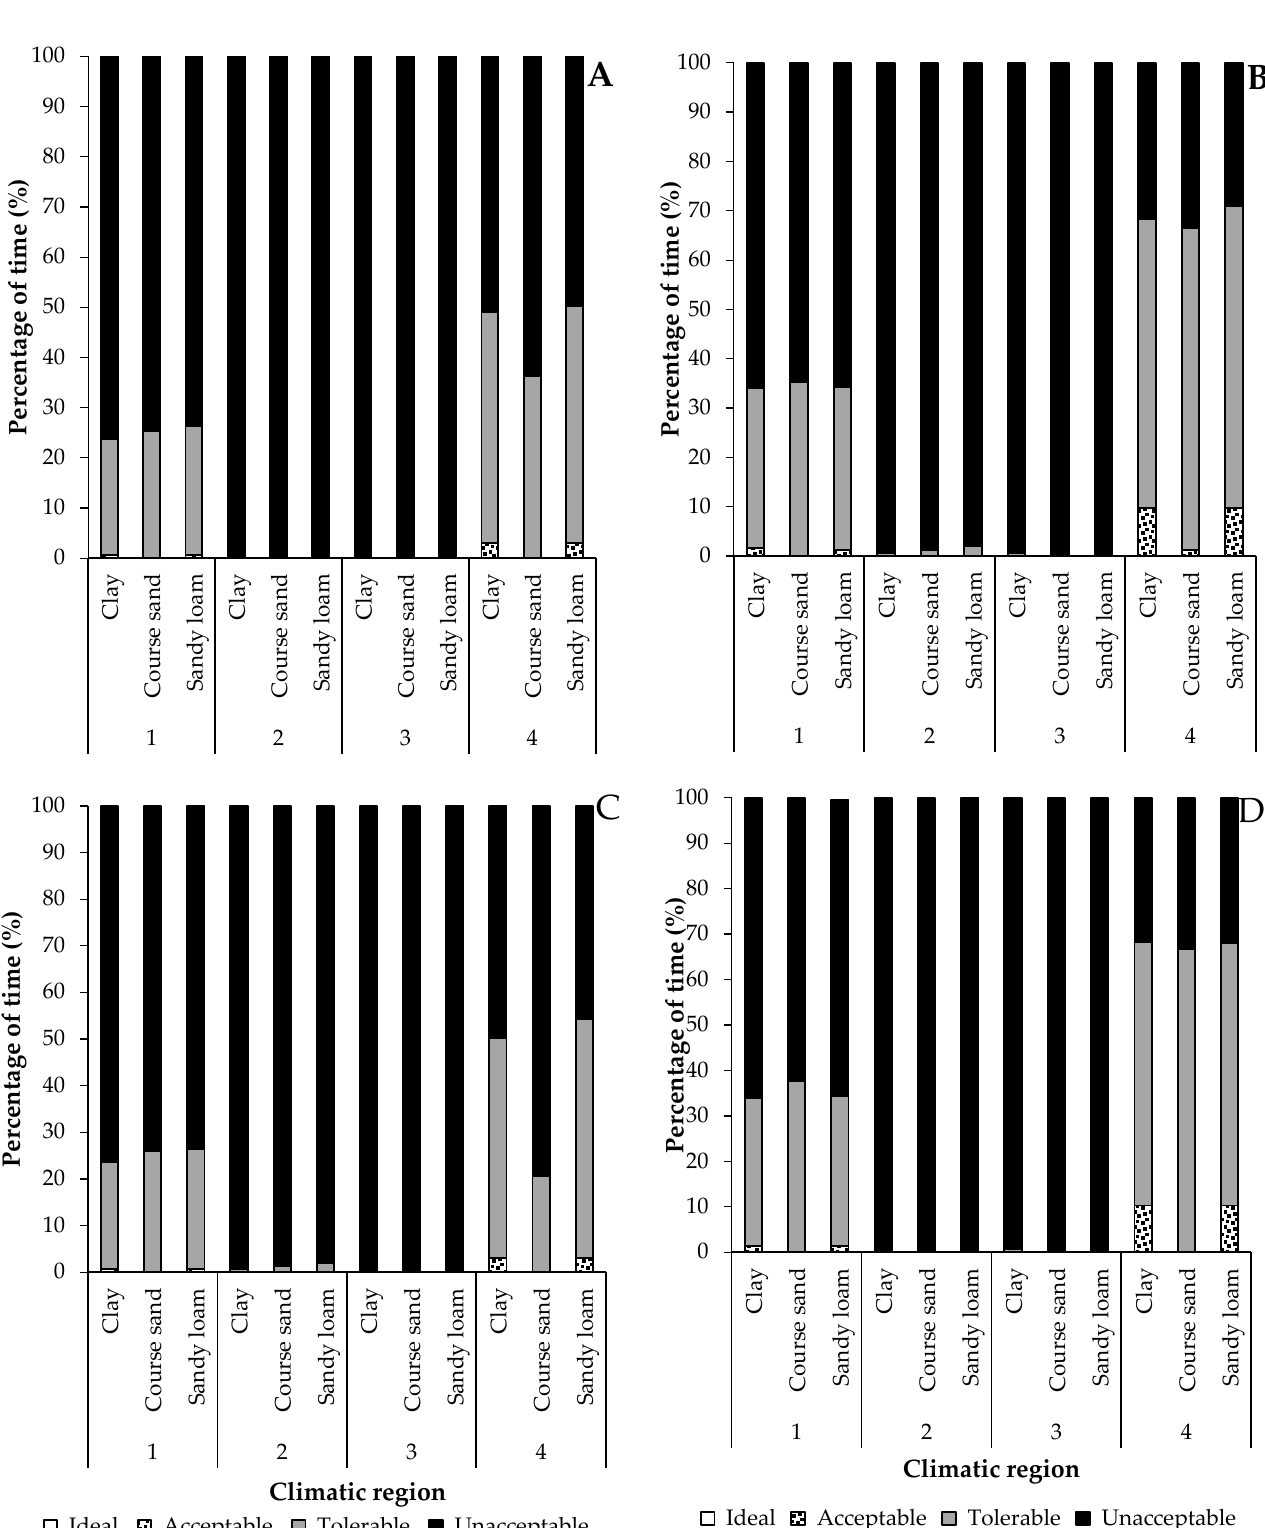
Figure 4. Assessment of AF effluent for fitness-for-Use; impacts of irrigation system and soil type on cabbage crop yield and quality in different climatic regions ( n = 3). ( A ) (Cabbage, N uptake, overhead irrigation), ( B ) (Cabbage, P uptake, overhead irrigation), ( C ) (Cabbage, N uptake, surface irrigation), ( D ) (Cabbage, N uptake, surface irrigation). 1; Climatic region 1, 2; Climatic region 2, 3; Climatic region 3 and 4; Climatic region 4.